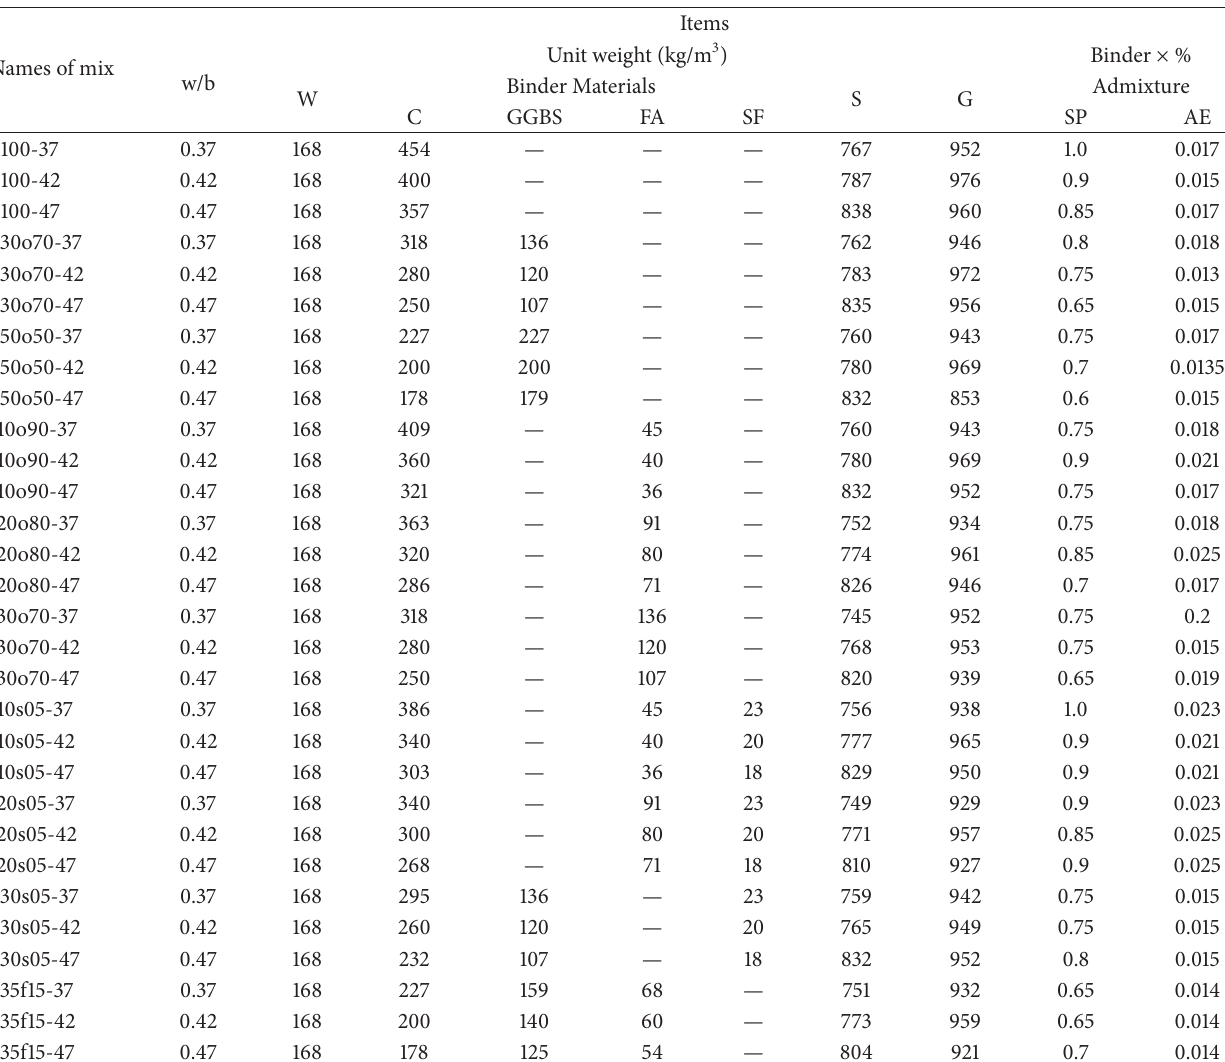
Table 3: Mix proportions for